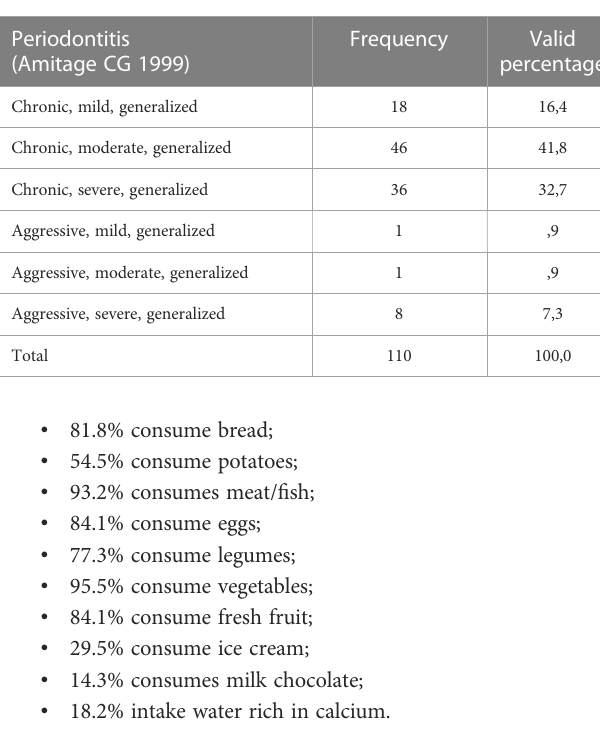
TABLE 4 Types of periodontitis found in the